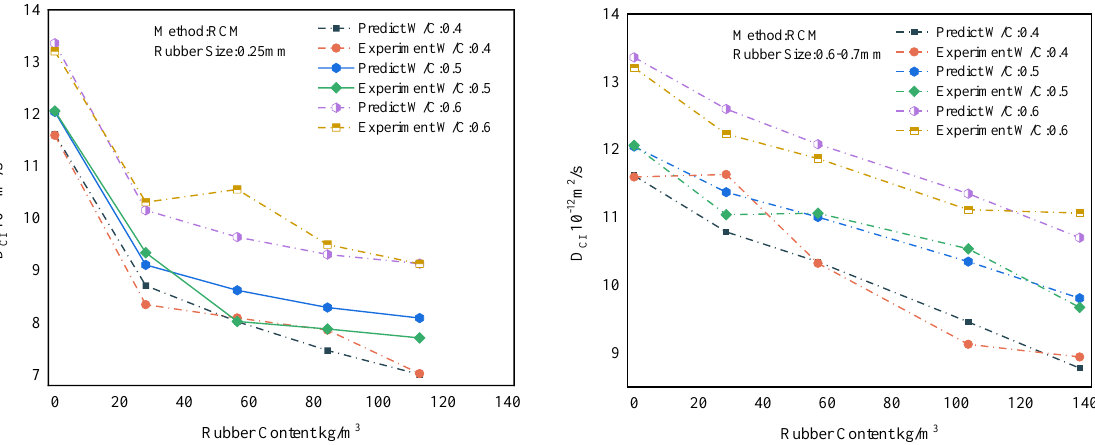
Figure 19. Prediction results of the MWOA-ELM model for the literature [56].